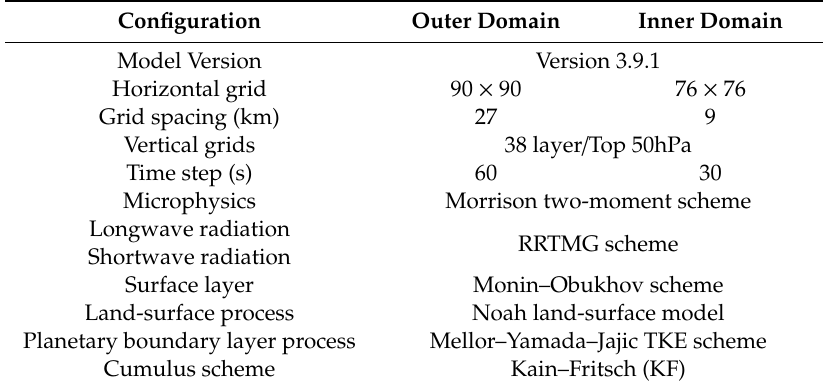
Table 1. Overview of the WRF model